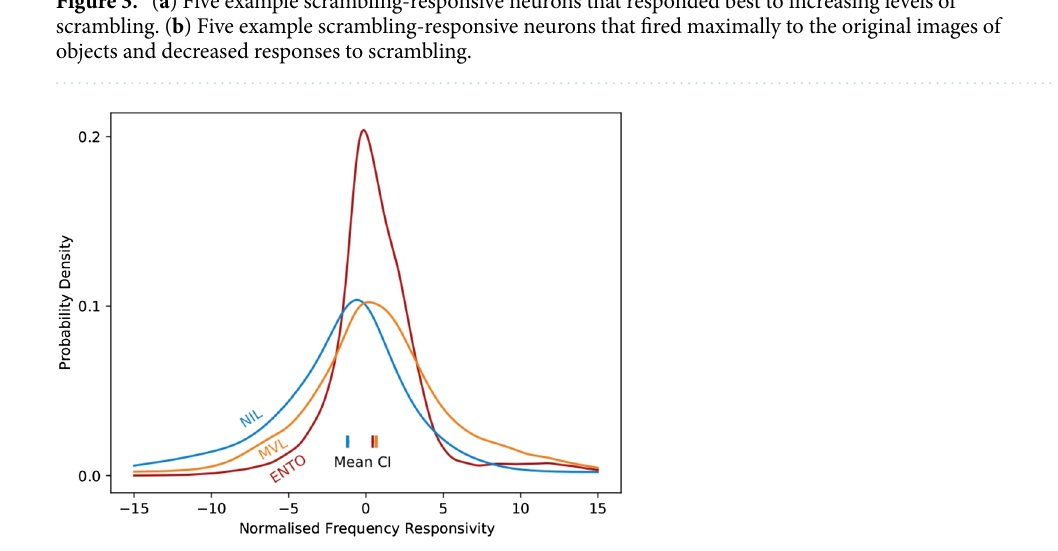
Figure 4. Posterior density distributions of response gradients resulting from the Bayesian GLM for ENTO, MVL and NIL. A large proportion of neurons in MVL and ENTO display a non-zero gradient, with a dependence on scrambling in the positive direction. In contrast a large proportion of neurons in NIL display a dependence on scrambling in the negative direction. Bayesian estimation tests 18 revealed significant differences between means (coloured at bottom) of the distributions of firing-rate vs. scrambling level slopes between all the three